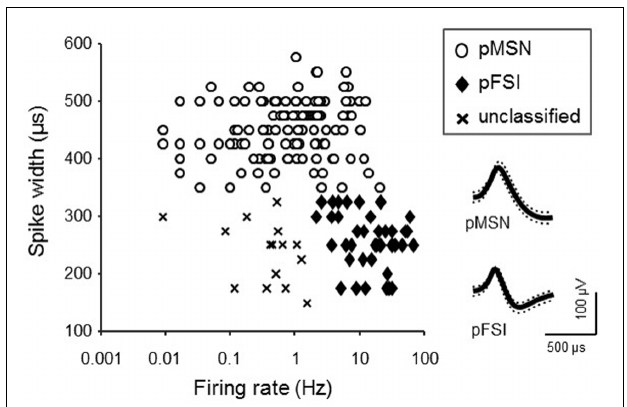
FIGURE 5 | Classification of NA neurons. The graph indicates a scatter plot showing electrophysiological properties (spike width and baseline firing rate) of each NA neuron. Symbols represent classes of NA neurons. Inset shows representative waveforms (mean ± SD, dotted lines) of pMSN and pFSI.